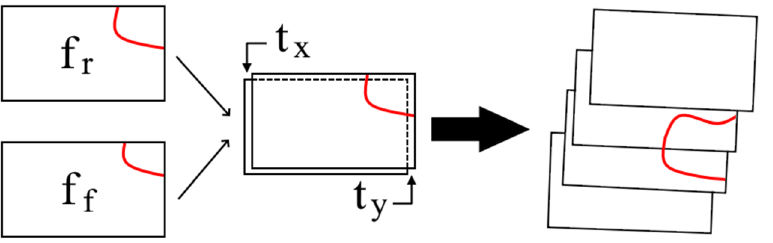
Figure 5. An outline of the general image registration process on an idealized feature (red line). Note that the spacing between the frames in the far right set have been exaggerated for clarity, and the middle pair of frames are more indicative of the usual spatial shift from frame to frame. f r is the moving frame’s registered coordinates, f f is the fixed frame’s coordinates, t x is the translation in the x direction, and t y is the translation in the y direction.